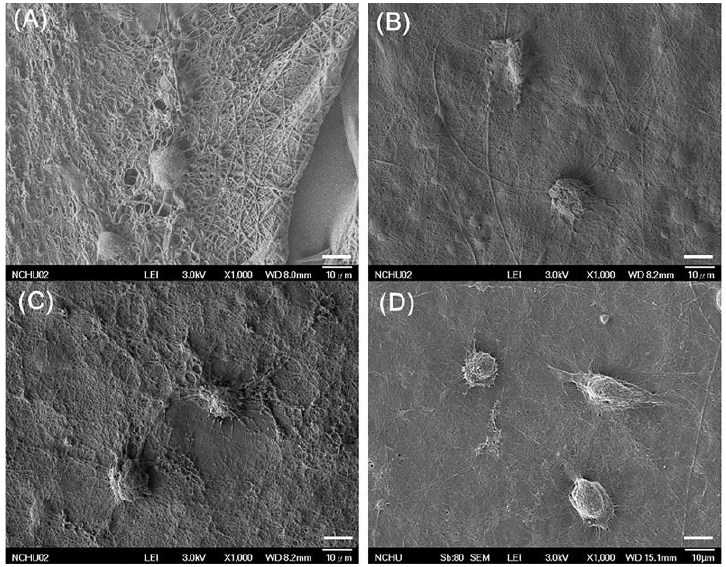
Figure 5. SEM images of L929 cells co-cultured with di ff erent GEL nanofibrous membranes for 24 hr.